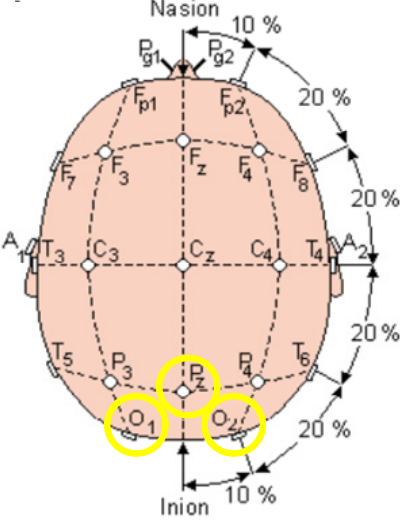
Figure 9. The configuration of channels for the EEG cap [29].